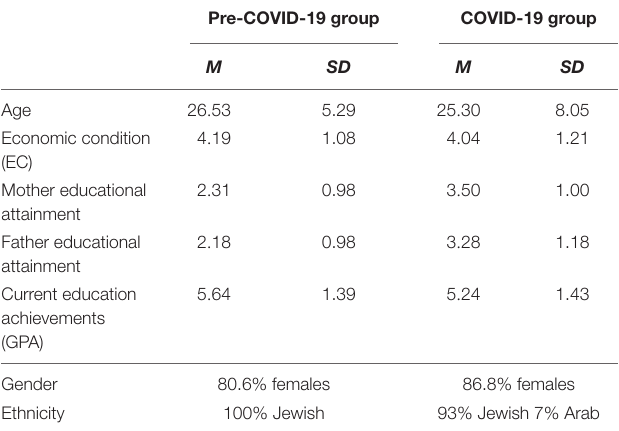
TABLE 1 | Student characteristics (pre-COVID-19 group and COVID-19